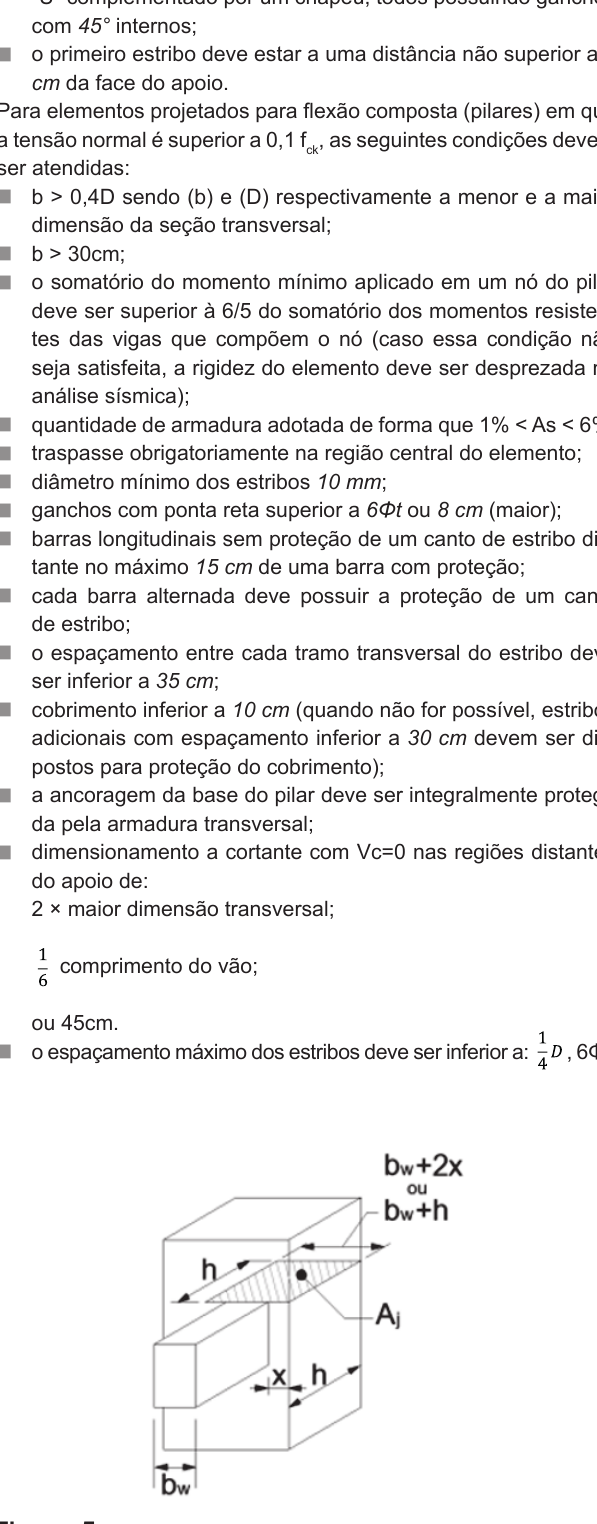
Figura 5 A em nó de j